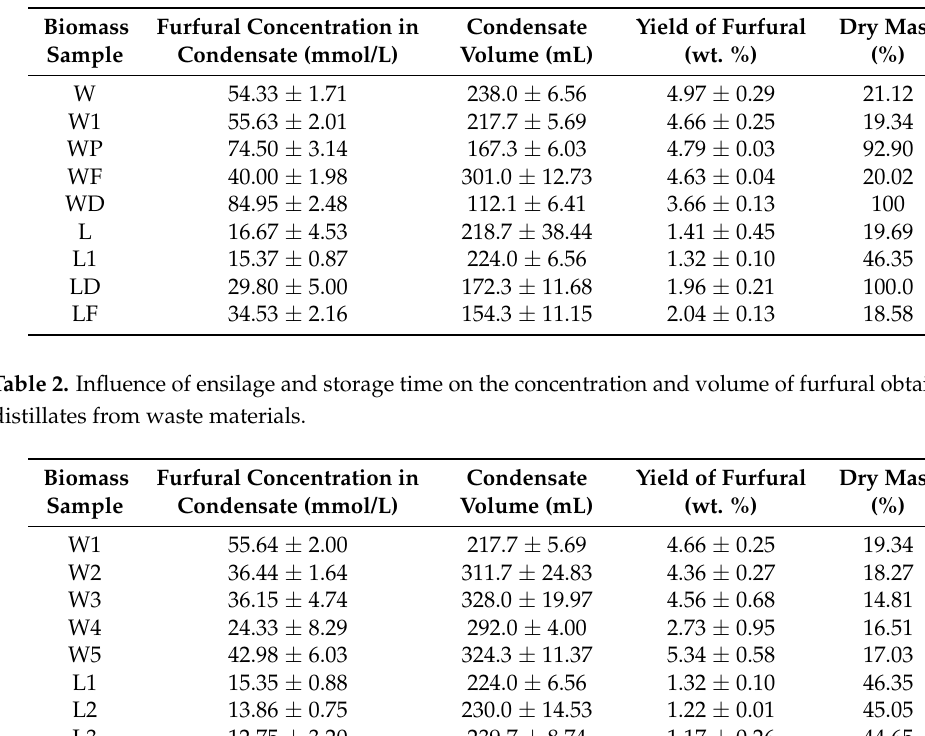
Table 1. Influence of preservation methods on the concentration and volume of furfural obtained in distillates from waste materials.